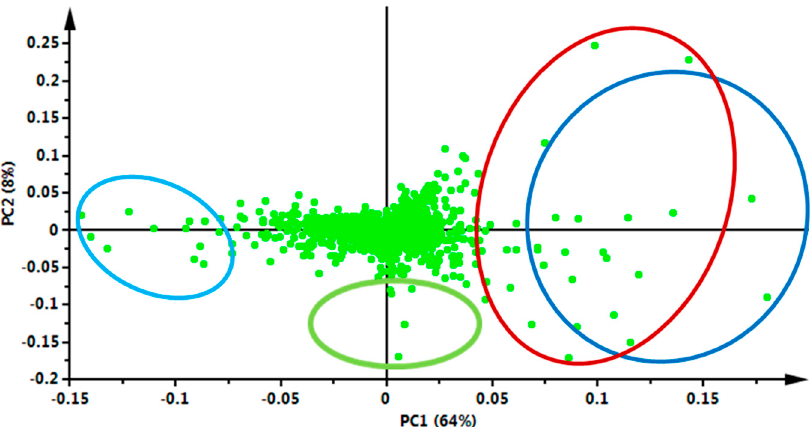
Figure 3. PCA loadings plot showing the selection of V. fastigiata metabolites associated with different extraction temperature conditions. The mass ions on the upper-left quadrant (light-blue ring) are associated with PHW extraction at 50 ◦ C; ions on the lower-right quadrant (green ring) are associated with extraction at 100 ◦ C, and ions on the right (upper and low; red and dark-blue ring) quadrants are associated with extraction at 150 ◦ C and 200 ◦ C. Table 1. Table listing annotated metabolites extracted from Vernonia fastigiata by pressurized hot water extraction (PHWE) Molecule Number